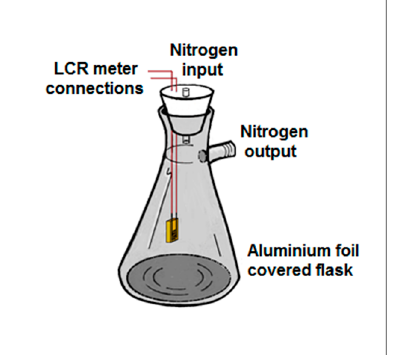
Figure 1. Schematic representation of the gas chamber used for sensor measurements.